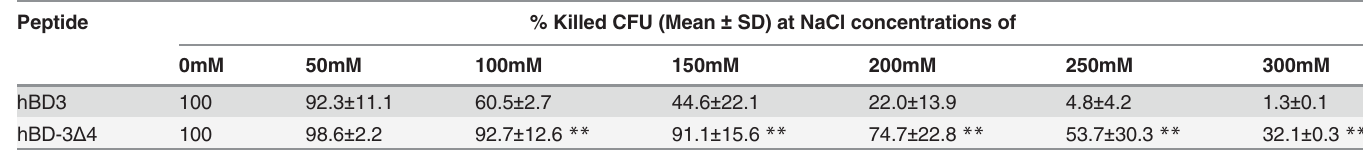
Table 3. Anti-bacteria activities of hBD-3 and hBD-3 Δ 4 against fi fteen E. coli clinical isolates at different NaCl concentrations.